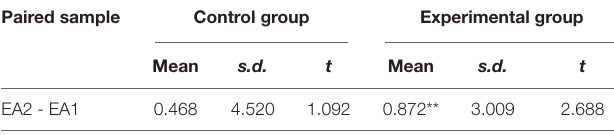
TABLE 4 | Conditional